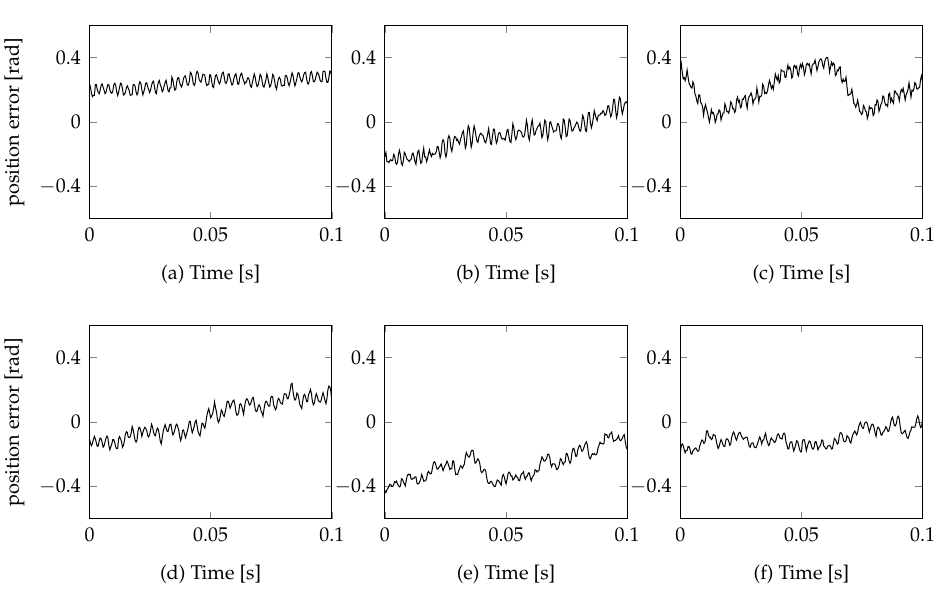
Figure 10. Estimated position errors at various Kalman matrices calculation update frequencies f b . The switching frequency 5 kHz and the rotor electrical angular speed 400 rad/s. ( a ) f b = 5 kHz, ( b ) f b = 2.5 kHz, ( c ) f b = 1.25 kHz, ( d ) f b = 500 Hz, ( e ) f b = 454 Hz, ( f ) f b = 416 Hz.